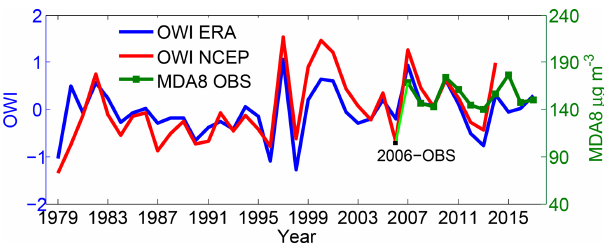
Figure 6. The variation in the JJA mean observed SDZ MDA8 (green) from 2006 to 2017, OWI calculated from ERA-interim datasets during 1979–2017 (blue) and OWI calculated from NOAA datasets during 1979–2014